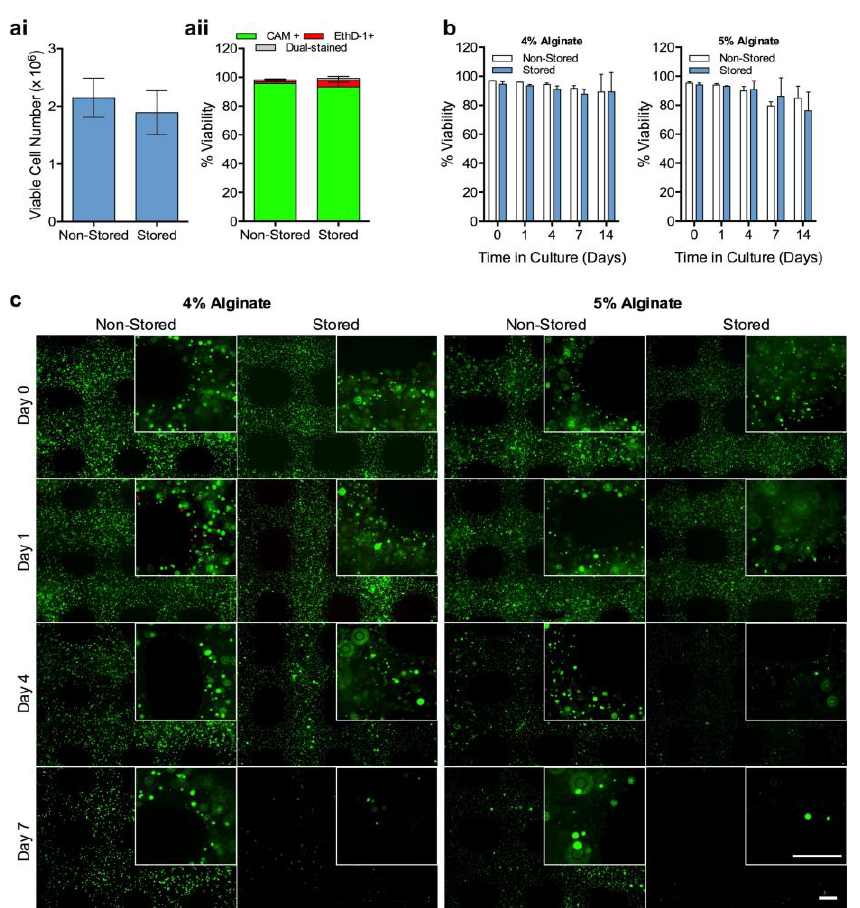
Figure 6. 3D bioprinting of storable cell-laden bioinks . 2 × 10 6 hASCs were encapsulated in calcium alginate beads and either used directly or stored for 7 days at 15 °C. Gels were dissolved in 50 mM sodium citrate before assessing viable cell recovery ( ai ) and % cell viability ( p < 0.05) ( aii ) from dissolved gels ( p < 0.05). Dissolved gels were mixed with HV-alginate, to reach final concentrations of either 4 or 5%, before printing lattice constructs using an extrusion-based bioprinter. Constructs were maintained under normal culture conditions for up to 14 days and percentage cell viability (% viability) ( b ) was calculated from live/dead (CAM/EthD-1) staining ( c ). Values are presented as means ± SD from 3 separate donors. p < 0.05 was considered significant. Scale bars = 0.5 mm.